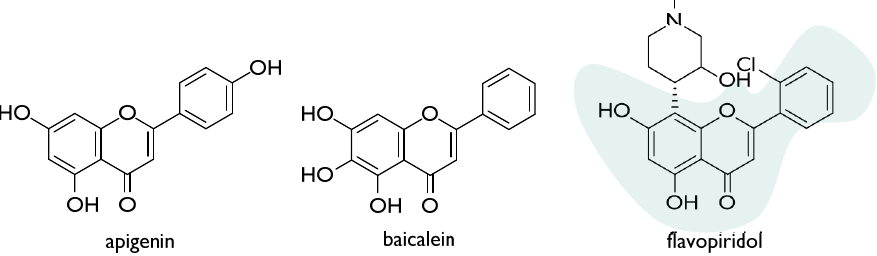
Figure 5 . Chemical structures of radioprotective natural (apigenin and baicalein) and Figure 5. Chemical structures of radioprotective natural (apigenin and baicalein) and semisynthetic semisynthetic (flavopiridol) flavones . (flavopiridol)